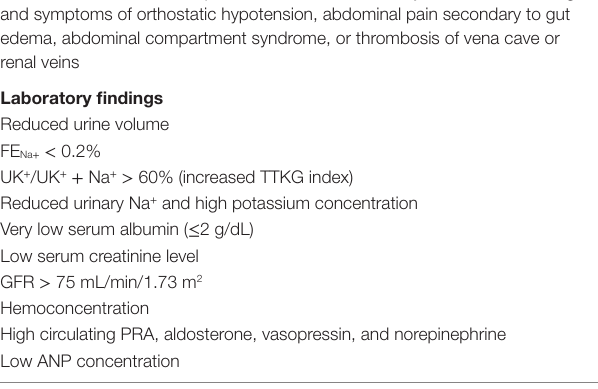
“underfilling.” Clinical characteristics Neuromuscular weakness, pallor, cool extremities, tachycardia, and other signs and symptoms of orthostatic hypotension, abdominal pain secondary to gut